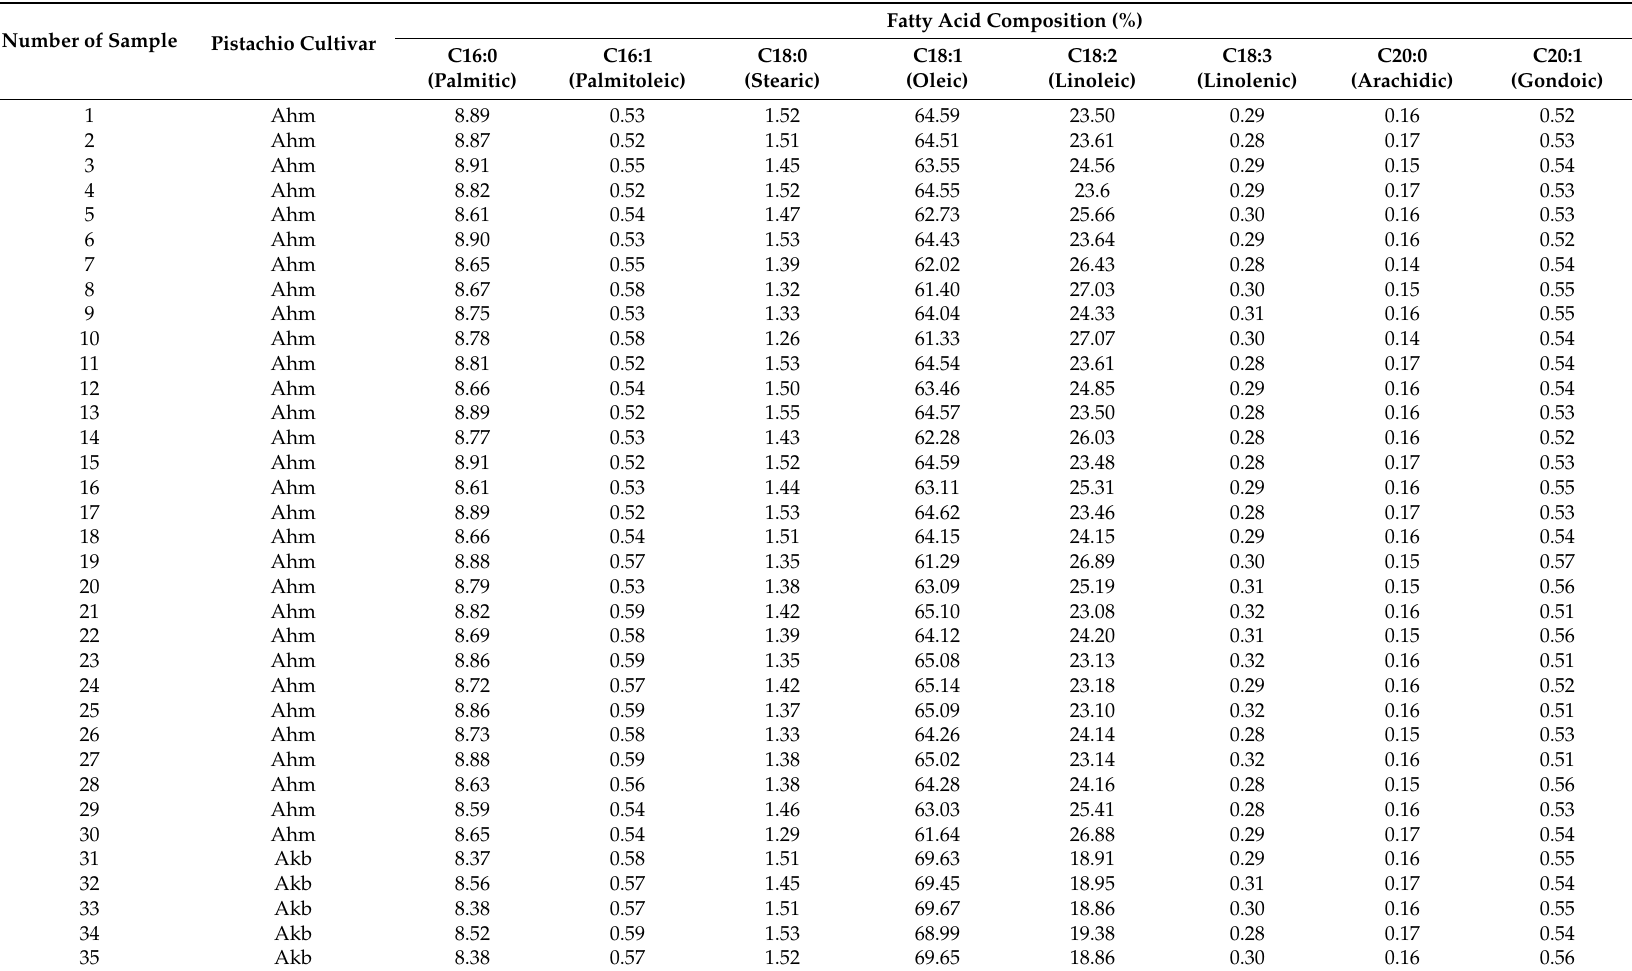
Table 1. Fatty acid composition (%) of pistachio oils of different